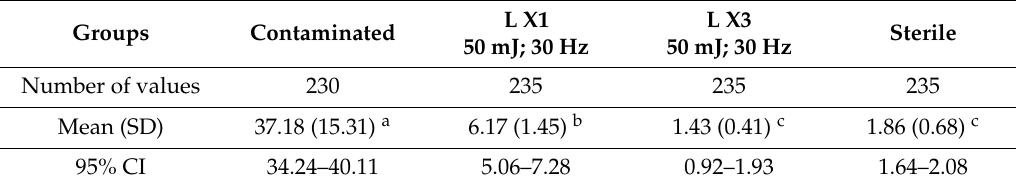
Table 2. Mean values (SD) of the Carbon mass (%) analysis according to the groups.